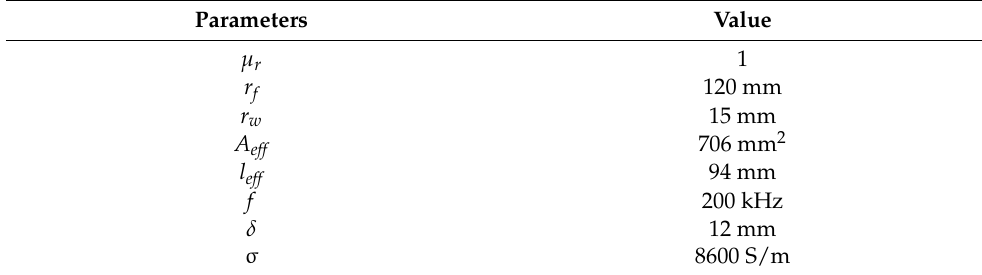
Table 1. Parameters of the fuselage equivalent coil.